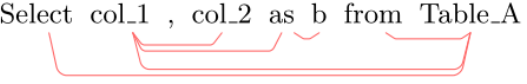
Figure 7. Predicted parse distance. This heat map shows the distance between two of these tokens. The light to dark color indicates the distance from near to far. For example, it can be seen that “ col_1 ” and “ col_2 ” are closest together, and they are at the same depth in the syntax tree. The results are mapped to the distance of each token in the parse tree, and tikz-dependent LaTeX is returned, exporting its constructed minimum spanning tree in PDF format, as shown in Figure 8.